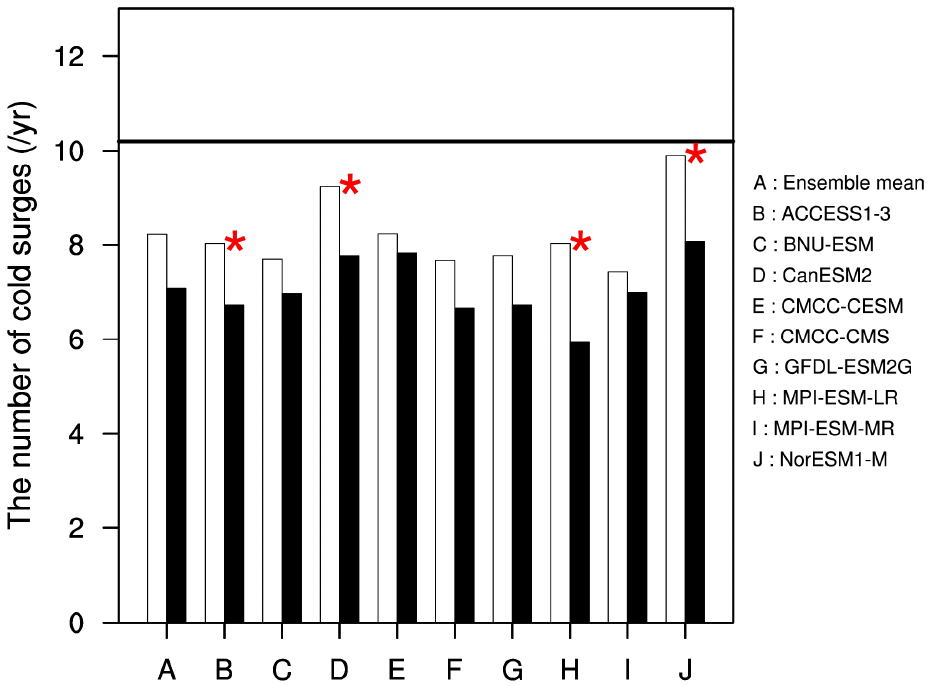
Figure 8. The number of cold surge occurrences (yr −1 ) in winter from 1979–2016 in observations (horizontal black line) and the historical (1975–2005; white bar), and future (RCP8.5; 2065–2095; black bar) from 9 CGCMs and their ensemble means (significant changes at 95% confidence level are represented by red stars).